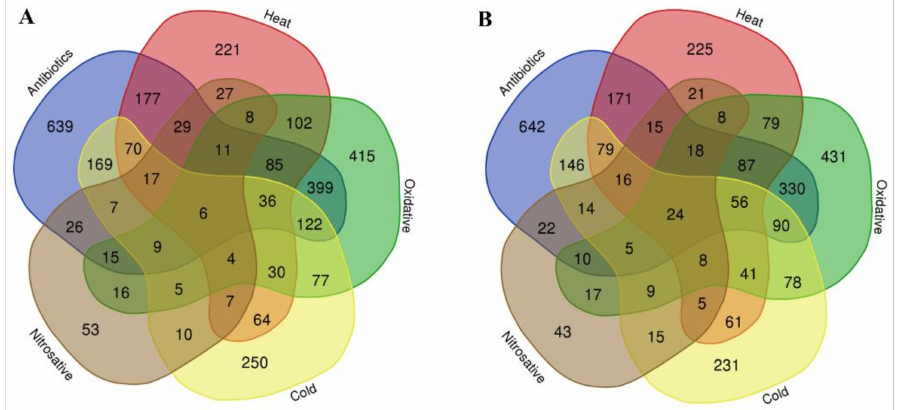
Figure 3. Venn diagram displaying the overlap of ( A ) upregulated and ( B ) downregulated genes within and between the five stress